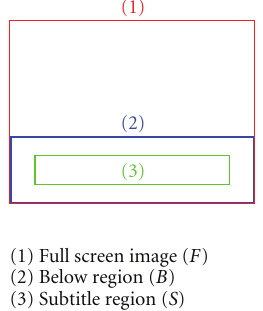
Figure 3: The image is divided into three regions.